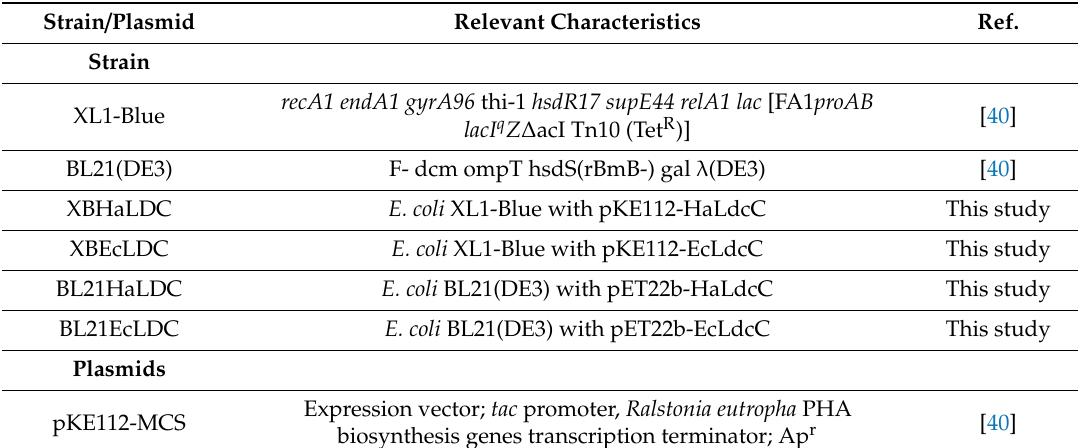
Table 1. Lists of bacterial strains and plasmids used in this study.